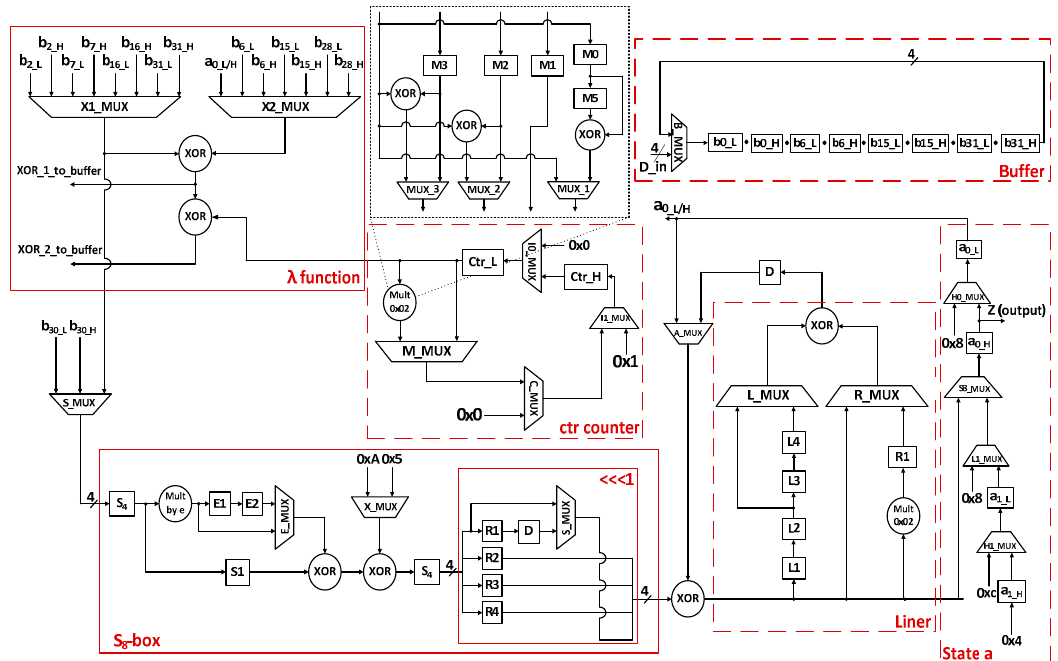
Figure 3. The proposed 4-bit architecture of Enocoro-128v2 stream cipher.